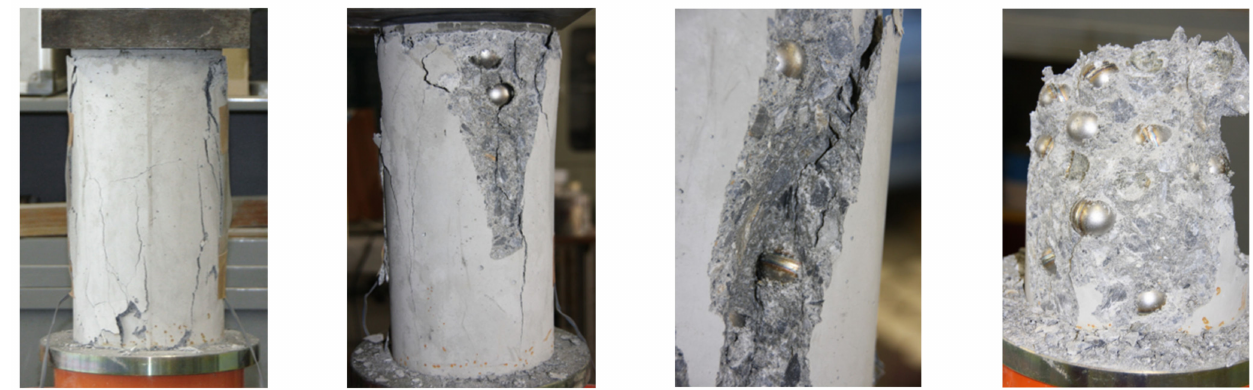
Figure 10. The failure picture of SB